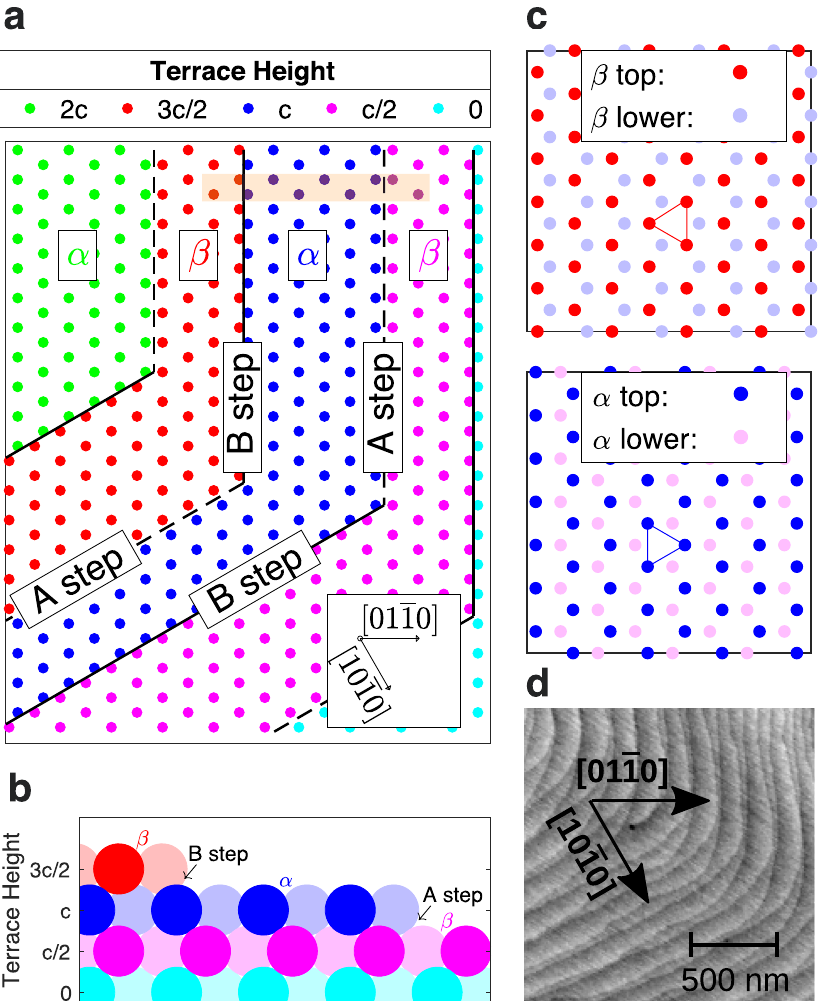
Fig. 2 Terrace and step structure of vicinal (0001) surface of an HCP-type crystal. For GaN, only Ga atoms are shown. a Circles show top-layer sites on each terrace, with color indicating height. Steps typically have lowest edge energy when they are normal to ½ 0110 (cid:2) , ½ 1010 (cid:2) , or ½ 1100 (cid:2) . Steps in a sequence have alternating structures, A and B , which swap when step azimuth changes by 60°. b Cross-section of the A and B step structures in the region marked by an orange rectangle in a . Lighter and darker colors indicate atoms in different rows. c Detail of α and β terrace structures. Orientation of triangle of top-layer atoms around 6 3 screw axis shows difference between layers. d AFM height image of GaN (0001) surface typical of fi lms grown on sapphire substrates by OMVPE, showing regions of alternating step spacings and interlacing at corners where the step azimuth changes. Step heights are c /2 = 2.6